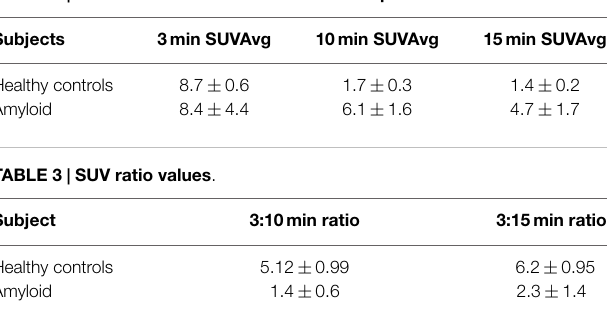
TABLE 2 | SUV measurements at different time points .